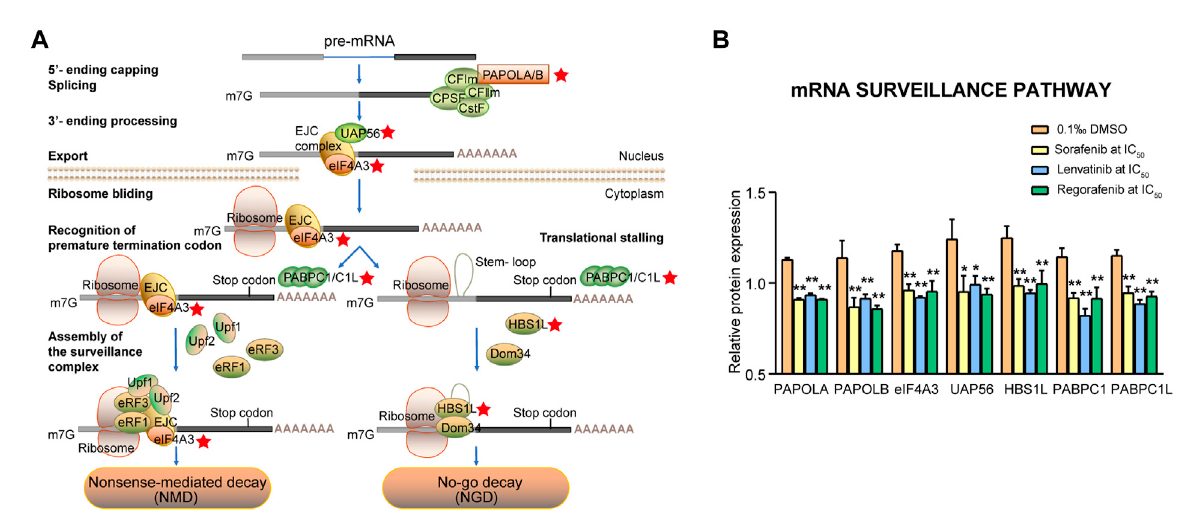
FIGURE 9 Commonly downregulated proteins involved in the mRNA surveillance pathway (A) and their relative expression (B) in Huh-7 cells treated by 72 h incubation with respective sorafenib, lenvatinib and regorafenib. Each bar presents mean ± SD ( n = 3). The * p < 0.05 and ** p < 0.01 versus DMSO. Star symbol in red color indicating the downregulation of the protein.